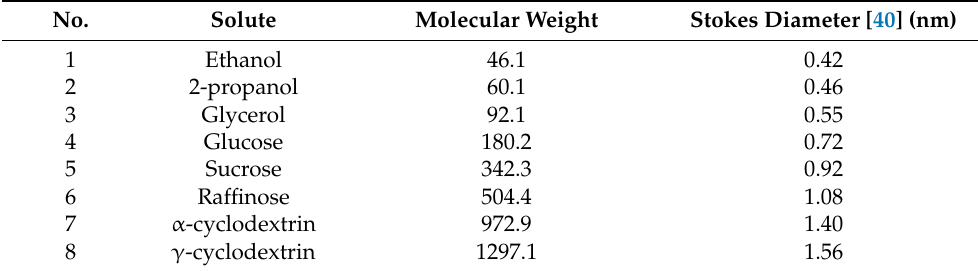
Figure 11. Neutral solute separation performance of hollow-fiber membranes before and after CPVA adsorption and cross-linking (XCPVA). The feed pressure and temperature were 5 bar and 25 °C. Solute concentration was 200 mg/L. Solid lines represent fitting curves according to Equation (4). MWCO values of the SPN-20/PPO hollow-fiber membrane and the XCPVA-modified membrane are 890 and 92, respectively. Table 2. Molecular weight and Stokes diameter of various solutes.